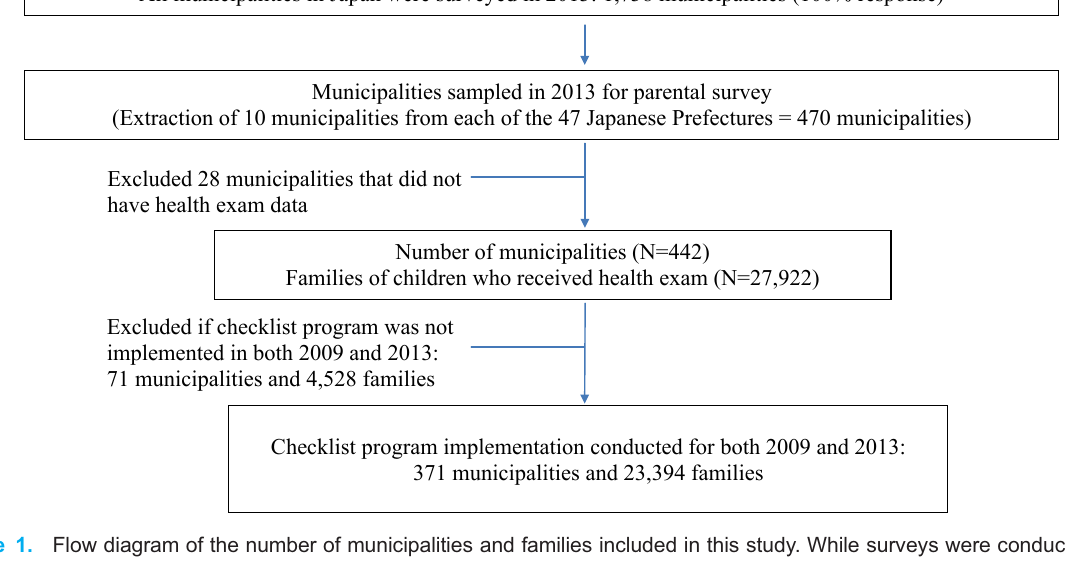
Figure 1. Flow diagram of the number of municipalities and families included in this study. While surveys were conducted over multiple years, this study focused on municipalities surveyed in 2013 and parental surveys administered at a child ’ s 1.5 month old health exam in